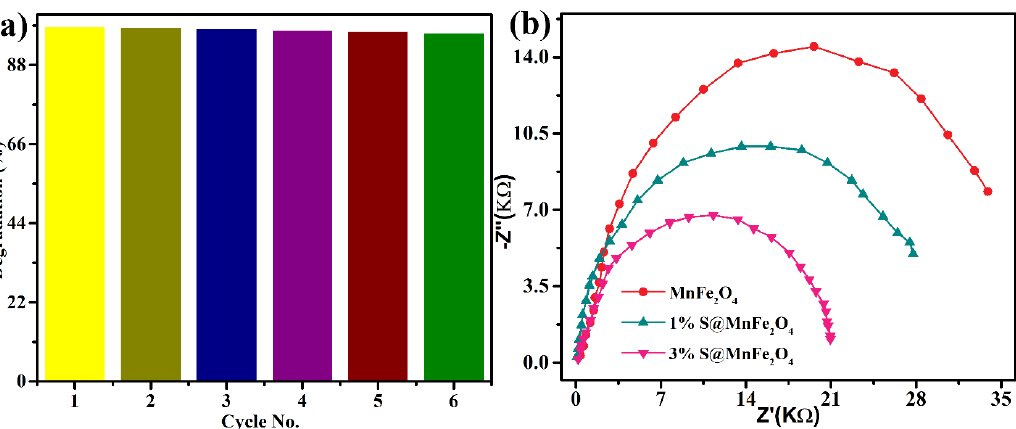
Figure 9. ( a ) the 3%S@Mn(Fe 2 O 4 ) photocatalysts’ cyclic stability up to the 6th cycle and ( b ) EIS Nyquist plots of Mn(Fe 2 O 4 ), 1%S@Mn(Fe 2 O 4 ), and 3%S@Mn(Fe 2 O 4